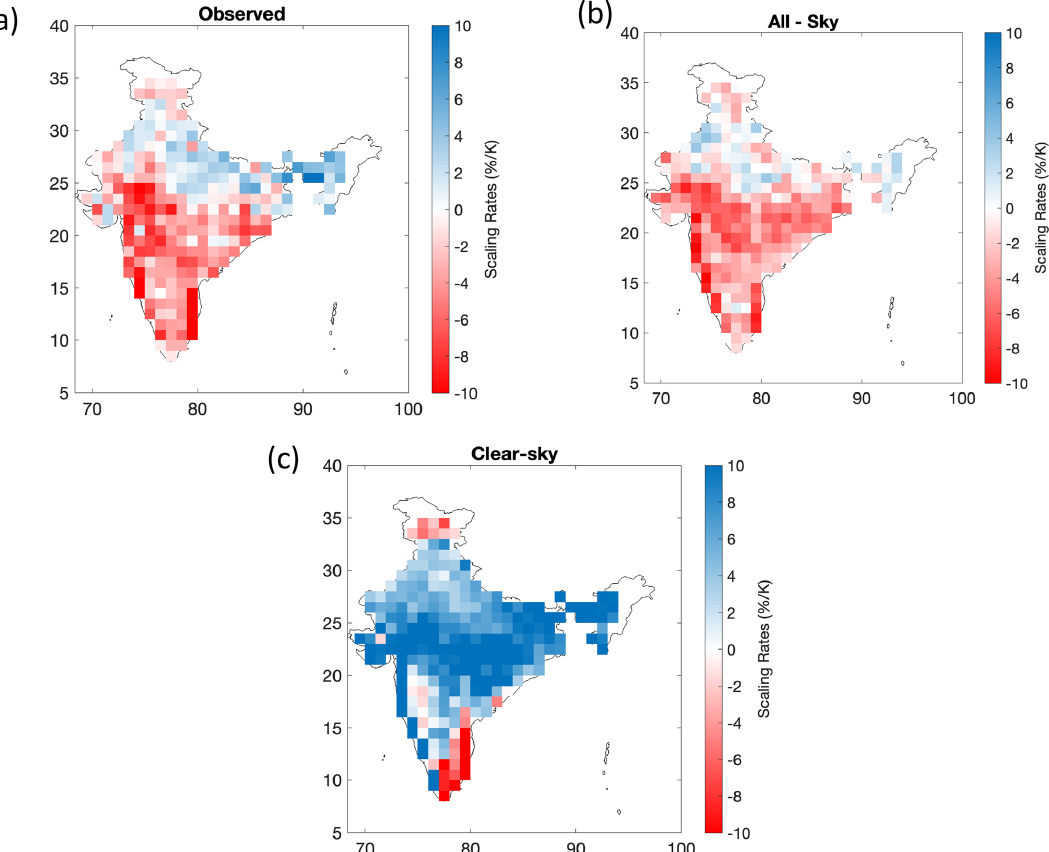
Figure B1. Regional variation of the 99th percentile daily precipitation–temperature scaling rates using (a) observed (b) all-sky and (c) clear- sky temperatures. Note that precipitation data are from the APHRODITE